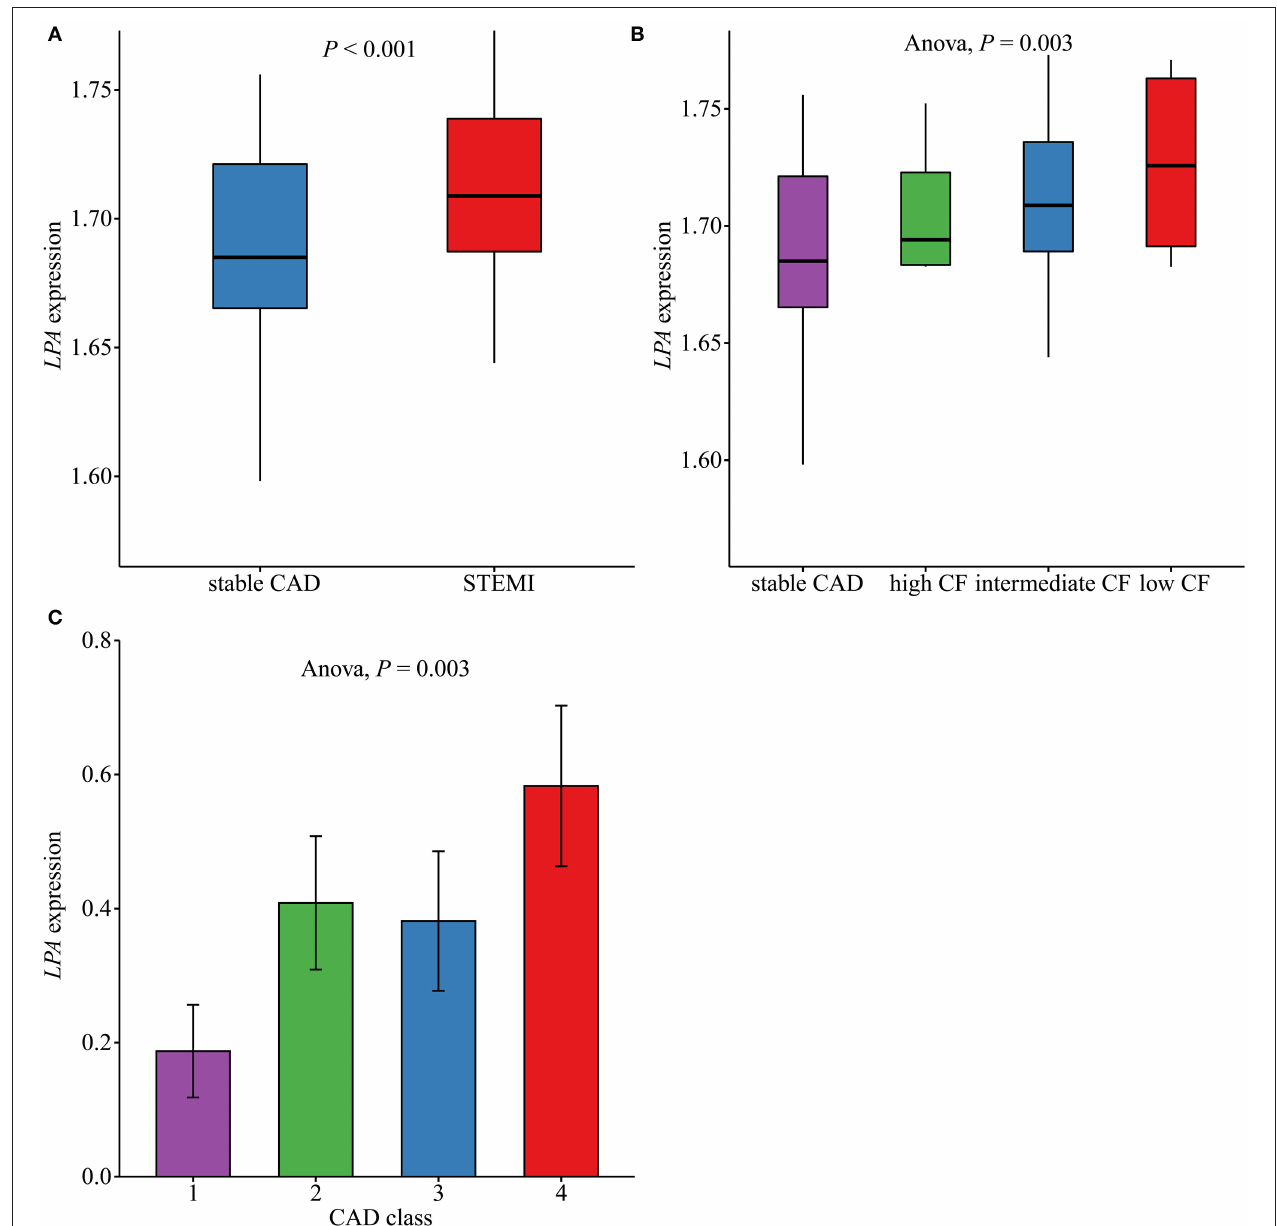
FIGURE 5 | Comparison of LPA expression levels in different groups. (A) The LPA expression levels in ST-segment elevation myocardial infarction (STEMI, n = 111) and stable coronary artery disease (CAD, n = 46) in GSE59867 ( P < 0.001). (B) LPA expression levels across low ( n = 9), intermediate ( n = 94), and high ( n = 8) cardiac function (CF) and stable CAD ( n = 46) groups in GSE59867 ( P = 0.003). (C) LPA expression levels across CAD class = 1 ( n = 32), 2 ( n = 31), 3 ( n = 26), and 4 ( n = 36) in GSE90074.